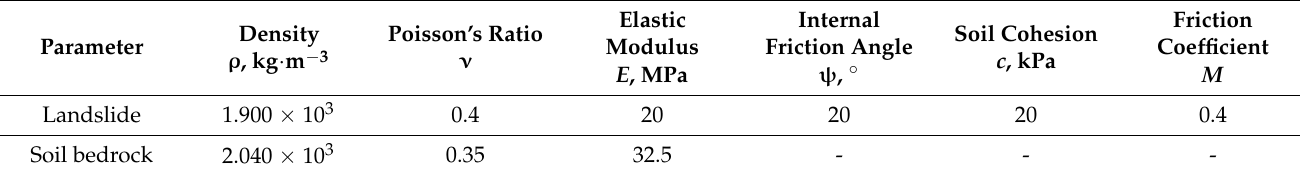
Figure 3. Three-dimensional view of landslide model. Table 1. Relevant parameters of lateral landslide soil.